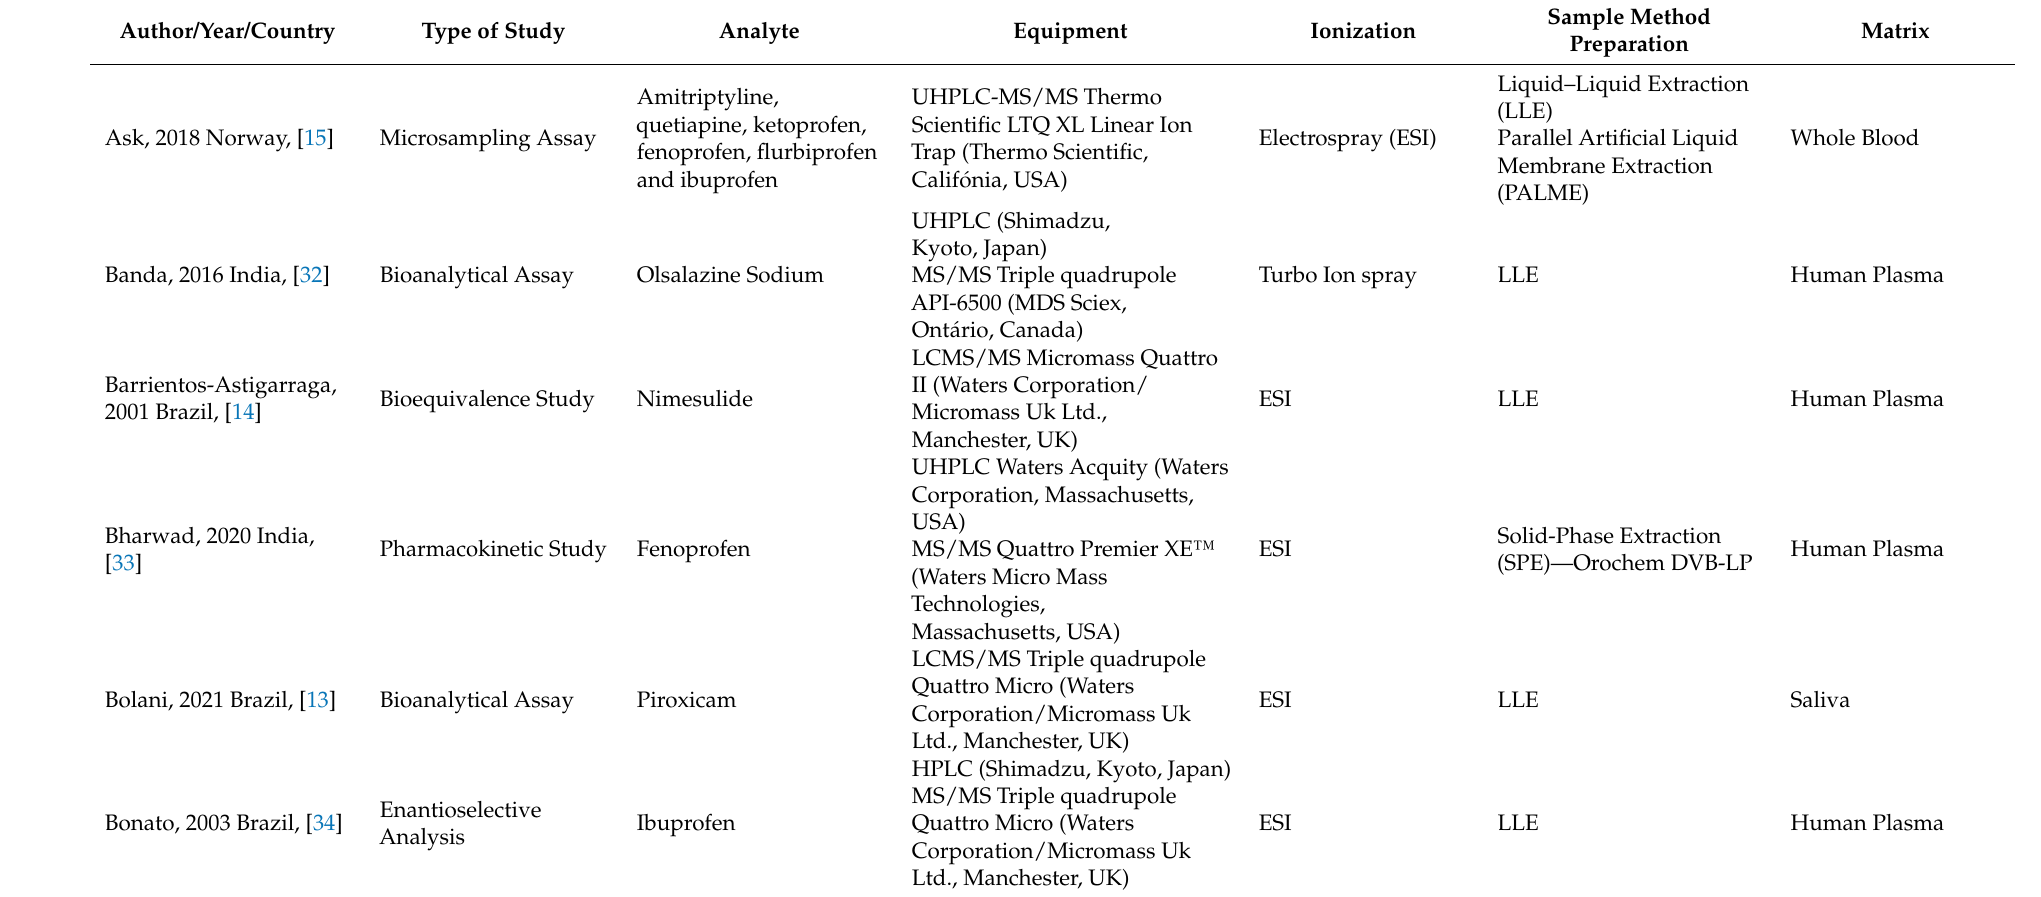
Table 1. Systematic investigation and analysis of different drug extraction